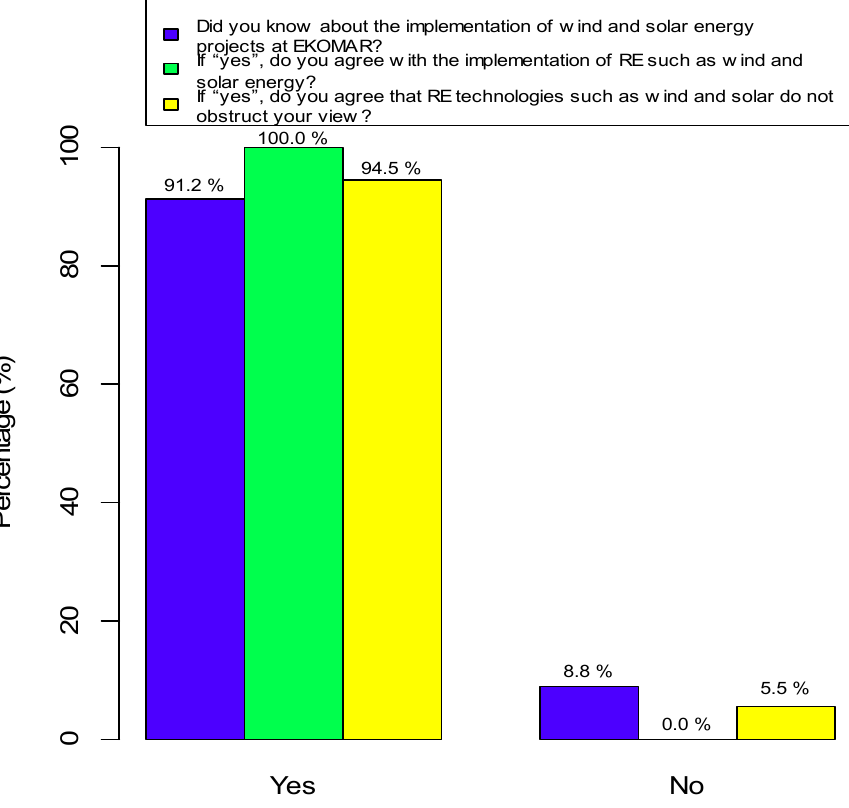
Figure 12. Respondents’ answers to “Yes” or “No” questions in Survey 2.